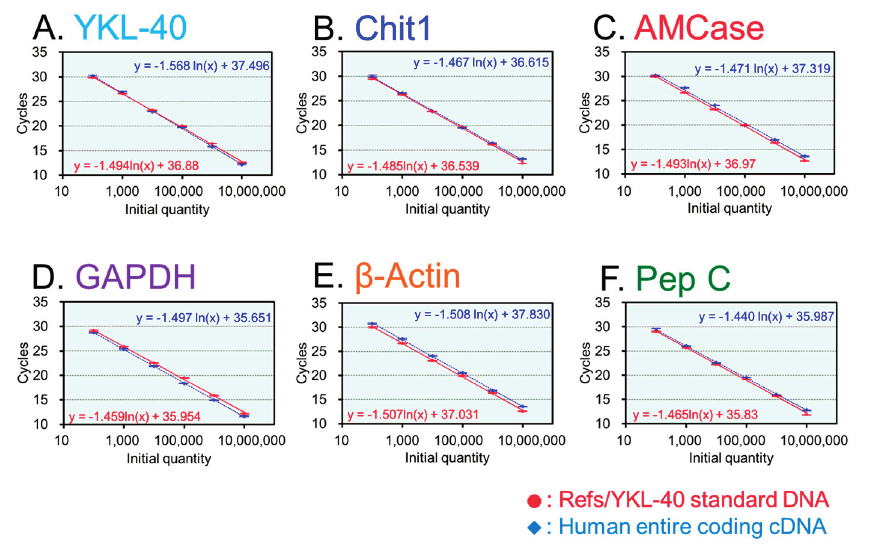
Figure 2. Validation of the qPCR system for the human tissues analysis. Following cDNAs were analyzed: ( A ) YKL-40; ( B ) Chit1; ( C ) AMCase; ( D ) GAPDH; ( E ) β -actin; and ( F ) pepsinogen C. Standard curves were obtained using the Refs/YKL-40 standard DNA containing six human cDNA fragments (red closed circles). In addition, the quantification of the human entire coding cDNA was performed using specific primer pairs for each gene. Target cDNA was amplified from a diluted sample of entire coding cDNA with a known concentration and subsequently analyzed as an unknown sample (blue closed rhombuses). Equal quantities were obtained for each tested dilution of the standard curve and entire coding cDNA. Data are expressed as mean ± standard deviation (SD) of three independent